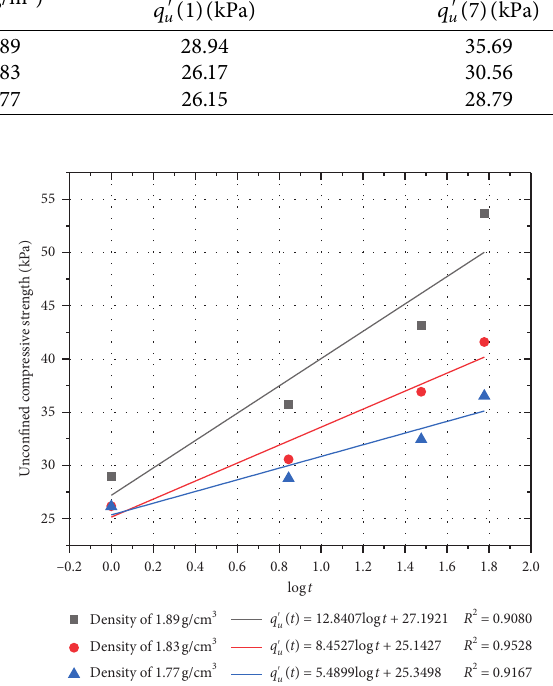
Figure 4: Relation curve q densities.